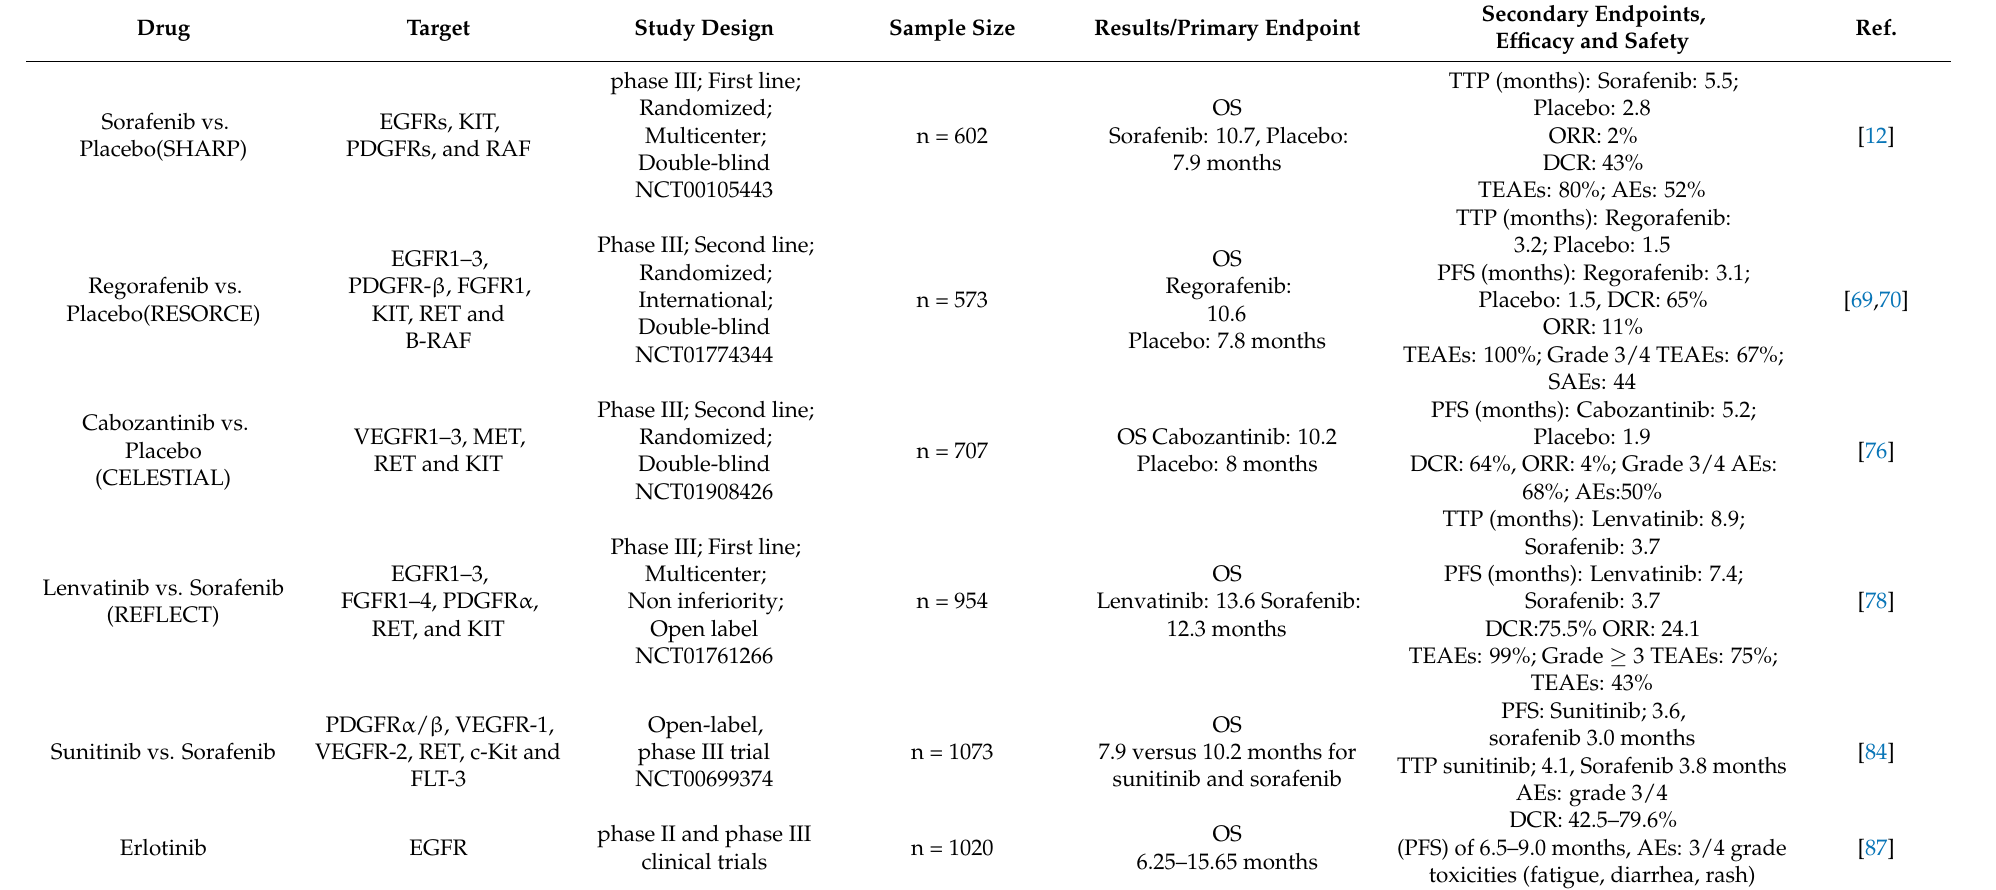
Table 1. The most recent in-vivo, in-vitro and clinical trials of tyrosine kinase inhibitors. EGFR, Epidermal Growth Factor Receptor; FGFR, Fibroblast Growth Factor Receptor; VEGFR, Vascular Endothelial Growth Factor Receptor; PDGFR, Platelet Derived Growth Factor Receptor; HGFR, Hepatocyte Growth Factor Receptor; IGF, Insulin Growth Factor Receptor. OS, overall survival; TTP, time to progress; TTRP, Time to radiologic progression; ORR, objective response rate; DCR, disease control rate; PFS, progress free survival; DCR, disease control rate; TEAE, Treatment Emergent Adverse Event. Study Design Sample Size Efficacy and